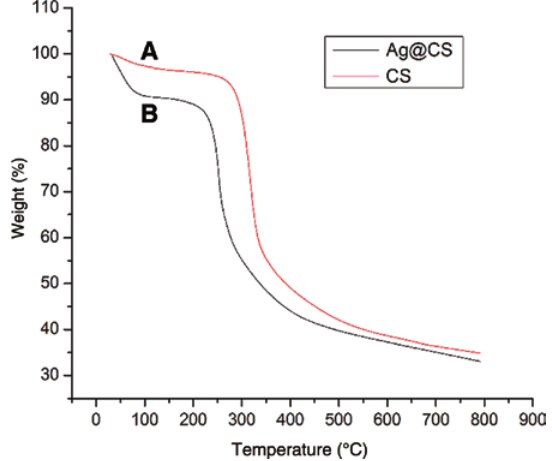
Figure 4: Thermogravimetric curves of CS (A) and Ag@CS